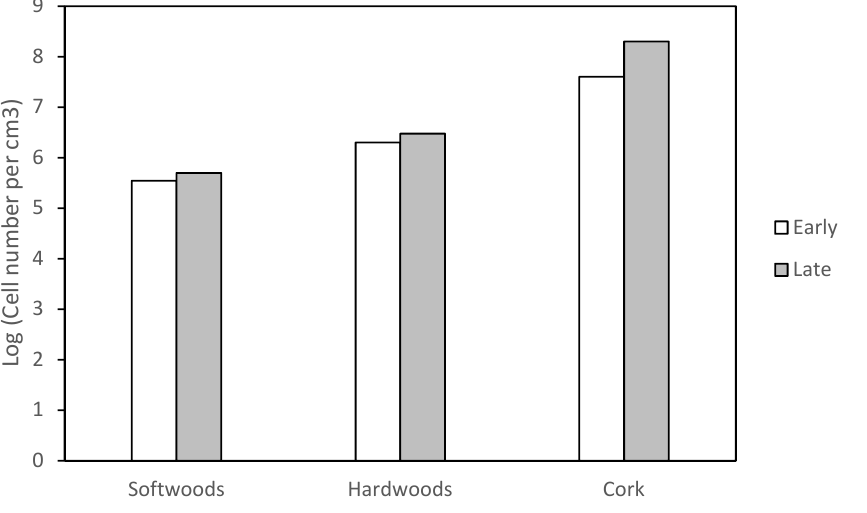
Figure 5. Comparison of the number of cells per cm 3 in softwoods, hardwoods, and cork, corre- sponding to earlywood and latewood, and earlycork and latecork cells, respectively [217,250].